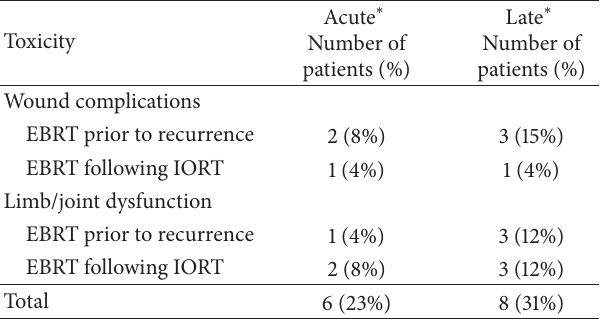
Table 3: Incidence of grade 3 acute and late